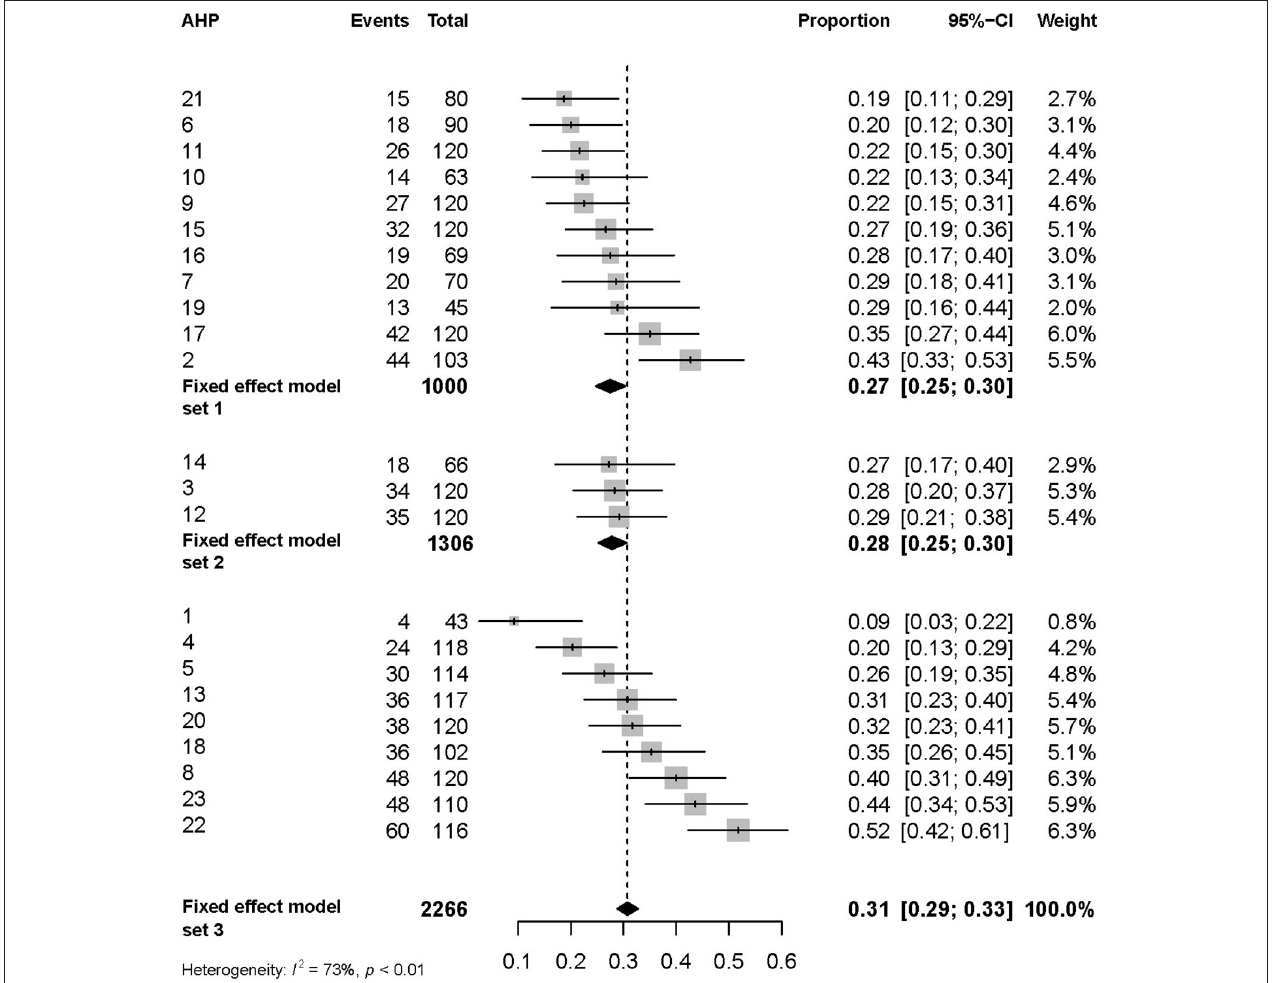
FIGURE 2 | Proportion of veterinary consultations that resulted in an antibiotic prescription in the WRLDj in 2017. Three estimates based on a sequential aggregation of data are reported (see “RESULTS” for details). All estimates suggest that about a third of the veterinary consultations resulted in the prescription of at least one antibiotic (“events”). The global assessment based on set 3 suggests a high level of heterogeneity in the prescription of antibiotics ( I 2 = 73%) across the animal health premises (AHP) sampled. AHP were numbered for